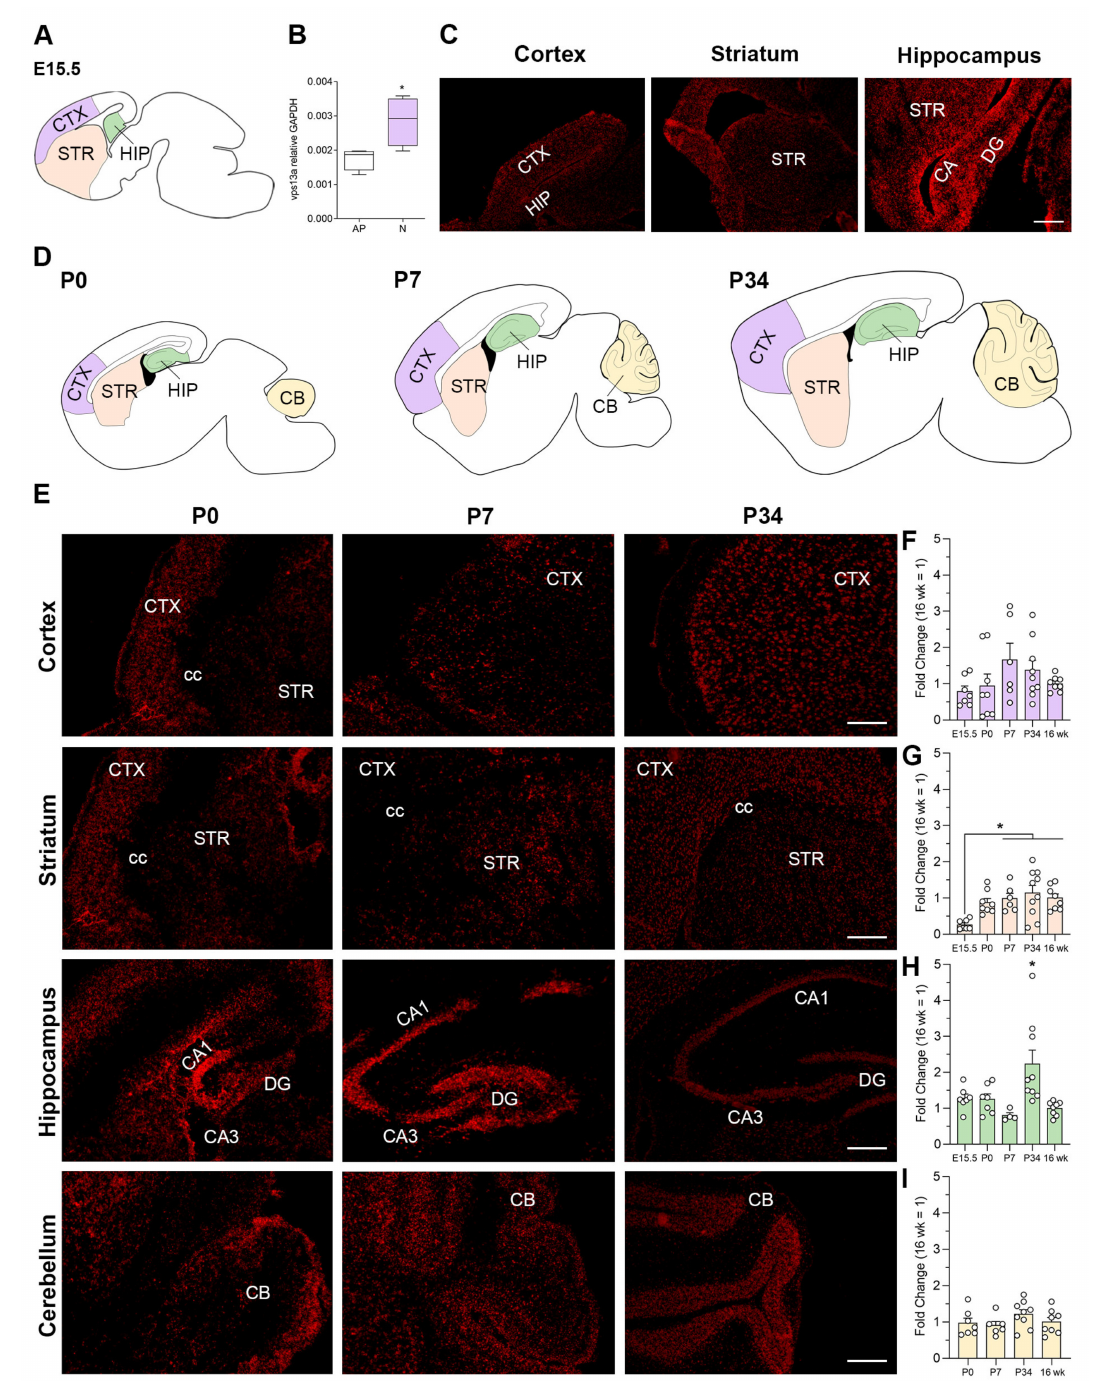
Figure 1. Vacuolar protein sorting the 13 homolog A (VPS13A) is mainly expressed by neurons and its expression is stable over time. ( A ) Drawing showing the location of the cortex (CTX), striatum (STR), and hippocampus (HIP) of a E15.5 mouse brain. ( B ) VPS13A expression in neurons and apical progenitors (AP) was quantified using single-cell RNA profiling data for the cortex, as published in Florio et al. (2015) (GSE65000) [24]. n = 15–20; *, p < 0.05, two-tailed Student’s t -test. Data are presented as whisker plots. ( C ) VPS13A mRNA staining in representative sagittal sections of the mouse brain. Scale bar 250 µ m; n = 3. ( D ) Drawings showing the location of the CTX, STR, HIP and cerebellum (CB) of a P0, P7, and P34 mouse brain. ( E ) Expression of VPS13A mRNA in representative sagittal sections of the mouse brain at the different stages. Scale bar 250 µ m; n = 3. VPS13A mRNA levels were analyzed at different stages in ( F ) frontal cortex, ( G ) striatum, ( H ) hippocampus, and ( I ) cerebellum. n = 8; * p < 0.05, the Bonferroni post-hoc test for CTX, STR, and CB and the Dunn test for